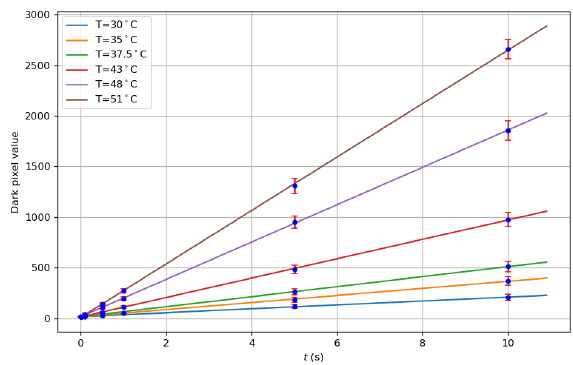
Figure 4. The mean value (blue point) and the standard deviation (red bar) of dark images as a function of the exposure time at different sensor temperatures. T 0 was fixed at 28.7 ◦ C , the lowest measured sensor temper- ature. t 0 was fixed empirically as 1 ms , a very short exposure time, at which the noise level is almost invariant over the en- tire temperature range of the sensor (Figure 5). The basic dark image B 0 was then obtained with t 0 and T 0 . The factor b was determined to be equal to 0.1237 ◦ C − 1 using least squares re- gression, leading to a doubling factor every 5.6 ◦ C , from